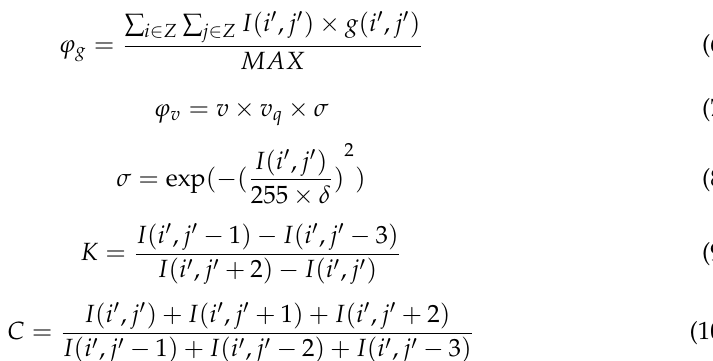
After the process of the wave potential energy equation and wave correction equation, the contour of the target can be obtained. In this paper, an image containing CME is selected to verify the extraction results of the omnidirectional wave operator in four directions separately and the fusion results of four directions, as shown in Figure 5. Considering that the image is a two-dimensional plane, a two-dimensional coordinate is established in the image plane. The rotation angle θ is the angle formed with any point A and its rotated point A (cid:48) , respectively, with the rotation center. When the operator turns to π /2, π , and 3 π /2, the operating direction is parallel to the positive direction of the y-axis, negative direction of the x-axis, and the negative direction of the